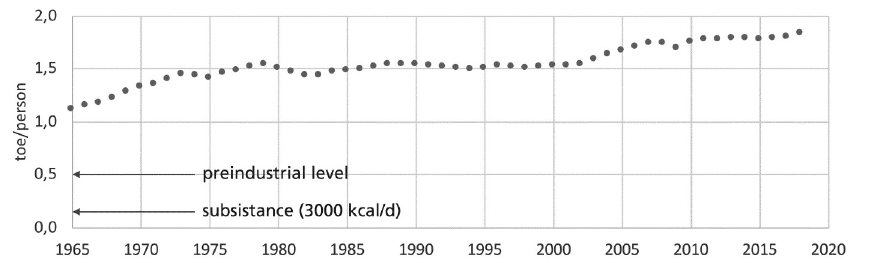
Fig. 4. – IHDI vs. Energy consumption per person (data from BP Statistical Review,